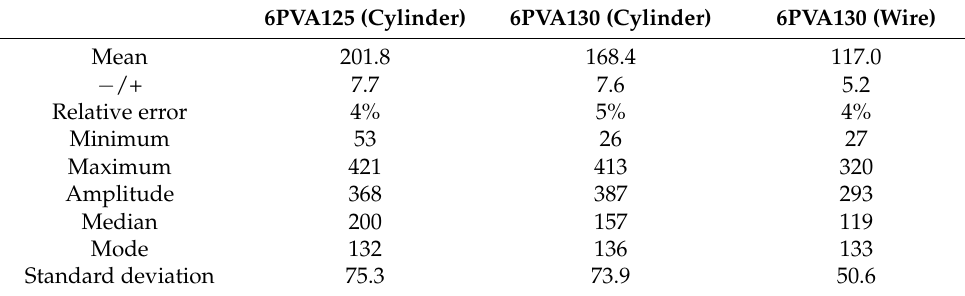
Table 5. Statistical data of electrospun fiber